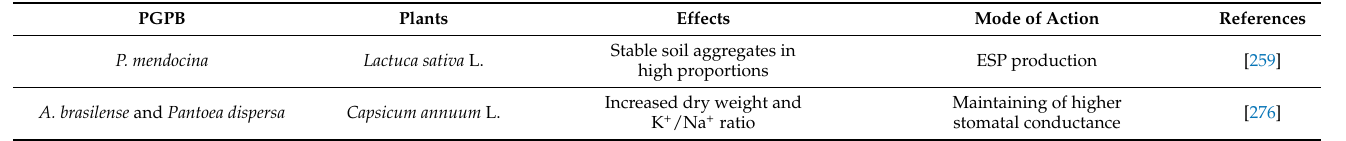
Table 2. PGPB-produced mechanisms related to tolerance against salinity